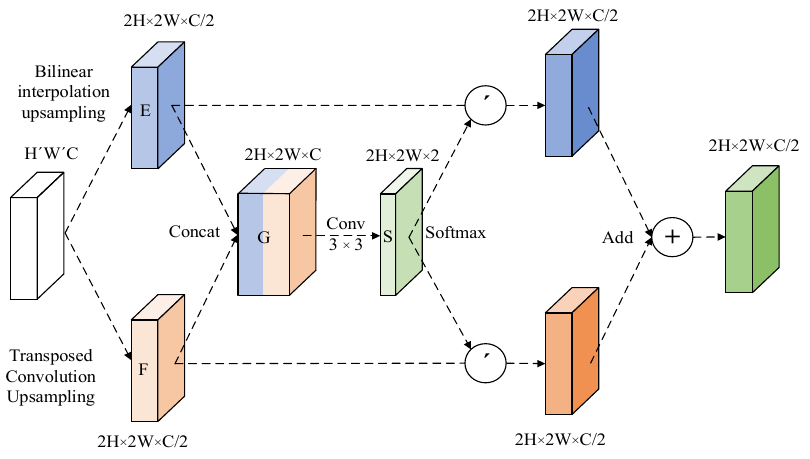
Figure 4. Adaptive upsampling module.